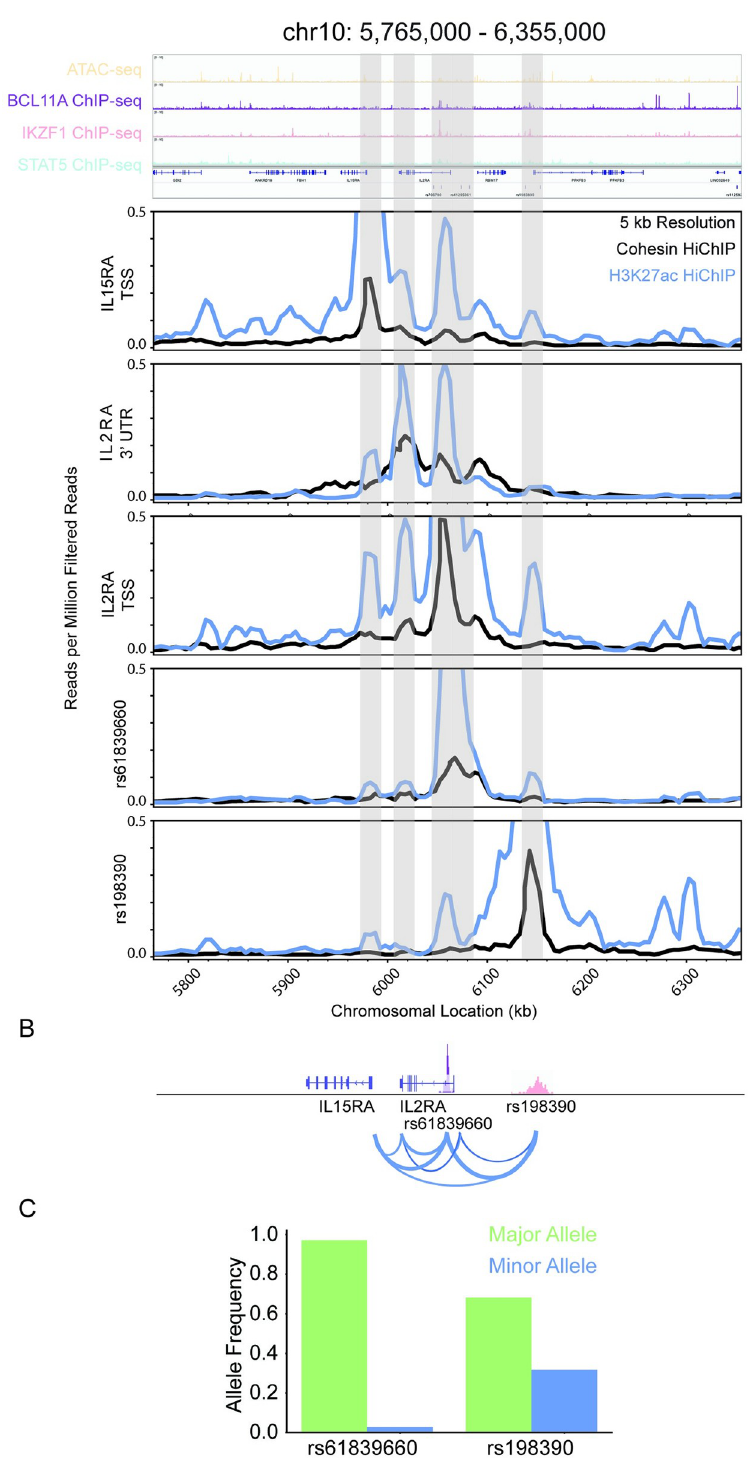
Fig 7. rs61839660 identified as a candidate for gene expression regulation of IL2RA and IL15RA. A: Visualization of the portion of the IL2RA gene regulatory network (chr10: 5,765,000–6,355,000). ATAC-seq and BCL11A, IKZF1, and STAT5 ChIP-seq raw read visualization (top panel). Cohesin (black) and H3K27ac (blue) HiChIP raw reads virtual 4C plots centered on the IL15RA TSS, IL2RA 3’ UTR, IL2RA TSS, rs61839660, and rs198390 (bottom panel). B: Schematic of the chromatin connectivity between the genetic variants and the genes as represented by the raw data